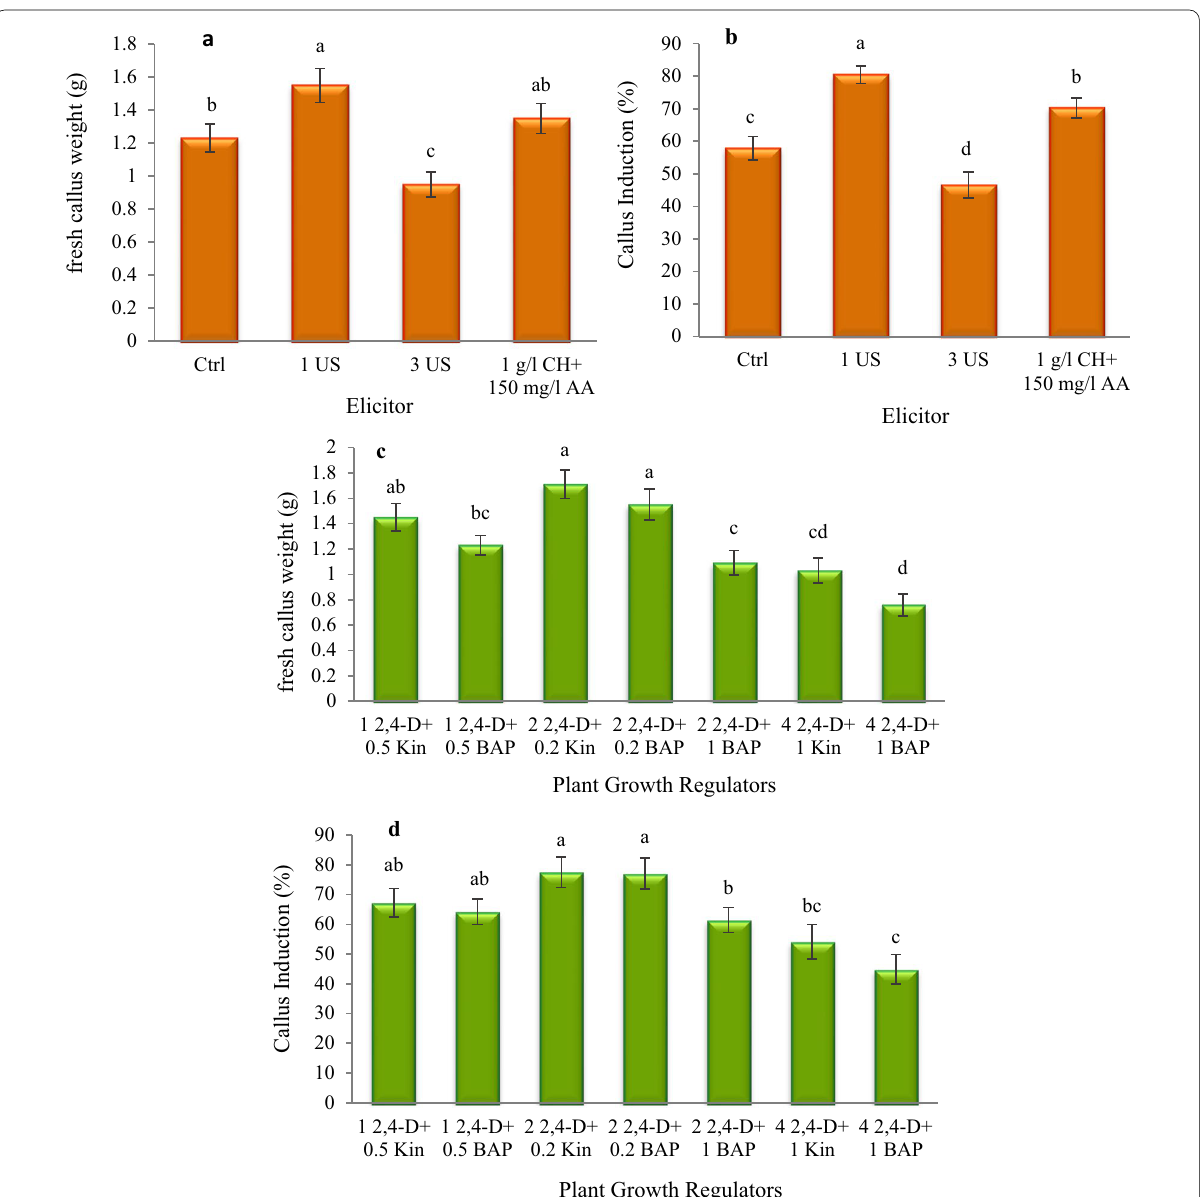
Fig. 2 The effect of elicitors ( a , b ) and growth regulators ( c , d ) on the percentage of callogenesis and fresh callus weight. According to Duncan’s multiple range tests, values with common letters are not significantly different at the 5% probability